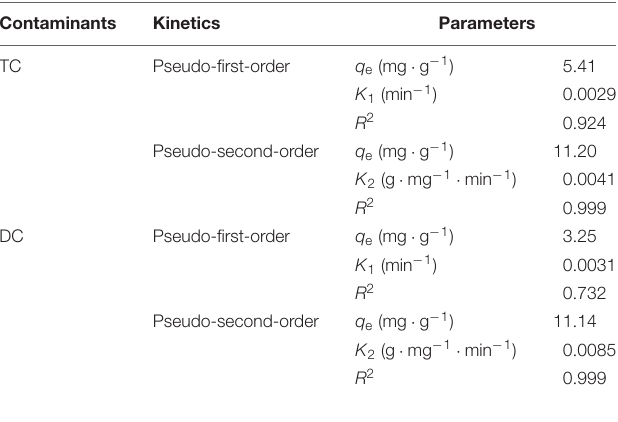
TABLE 4 | Model parameters and corresponding correlation coefficients of kinetics models.